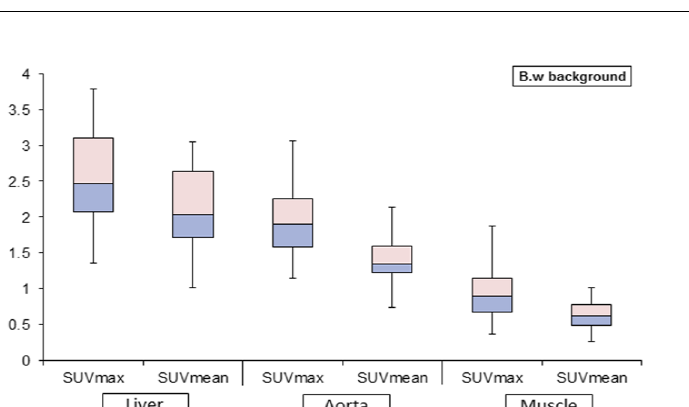
Fig. 1 The average SUV value of liver, aorta, and muscle for lymphoma patient group as a background using SUV max and SUVmean